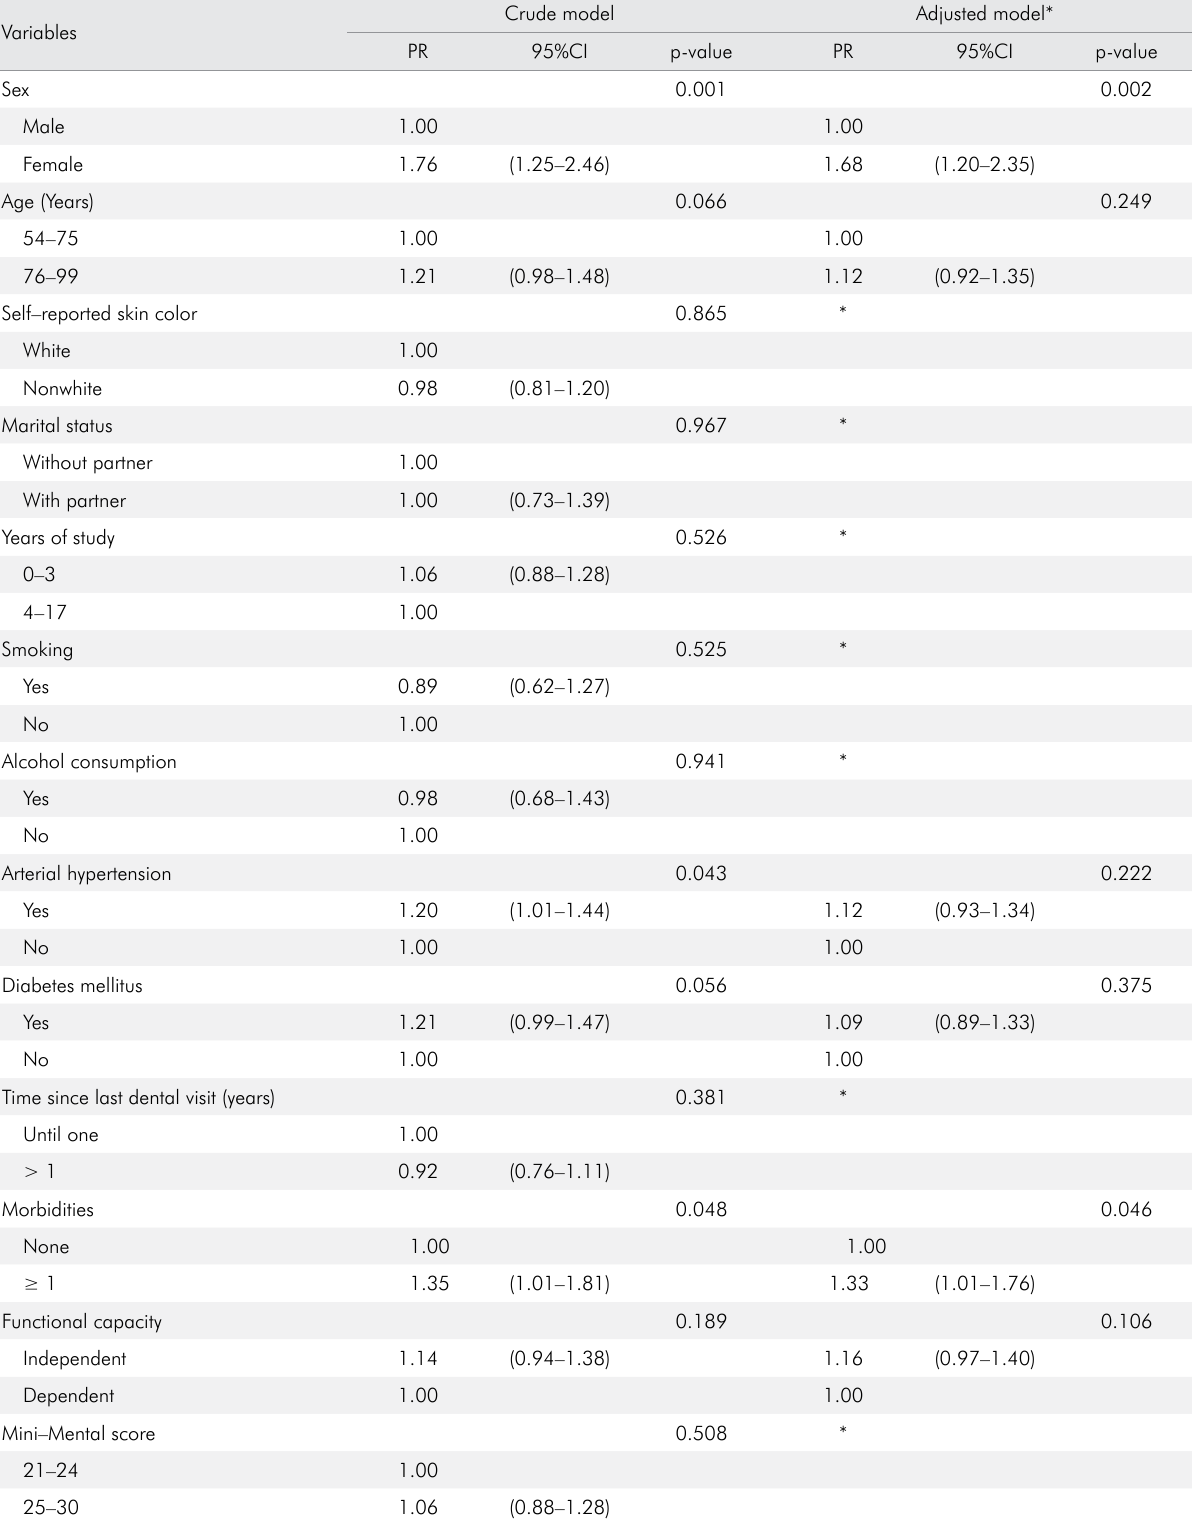
Table 3. Crude and Adjusted Prevalence Ratios and Confidence Intervals 95% (95% CI) of occurrence of use of dental prostheses according to independent variables in institutionalized elderly. Belo Horizonte, Brazil,